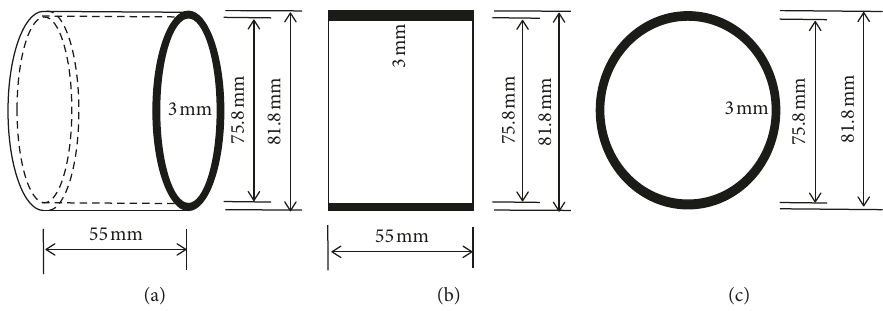
Figure 3: Basic dimensions of steel sleeve. (a) Stereogram. (b) Transverse profile. (c) Vertical profile.